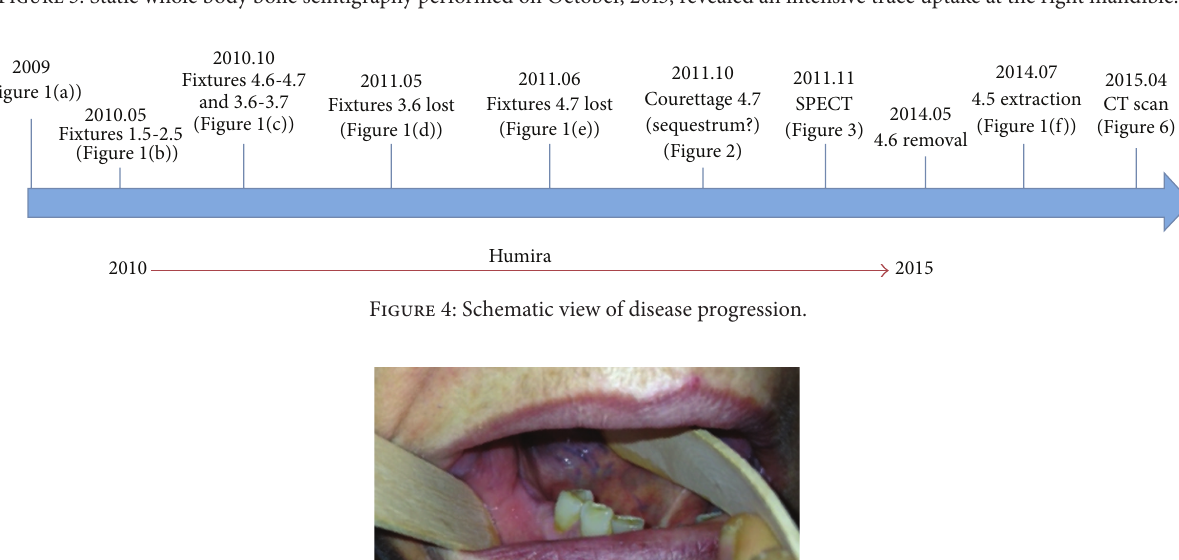
Figure 3: Static whole body bone scintigraphy performed on October, 2013, revealed an intensive trace uptake at the right mandible.